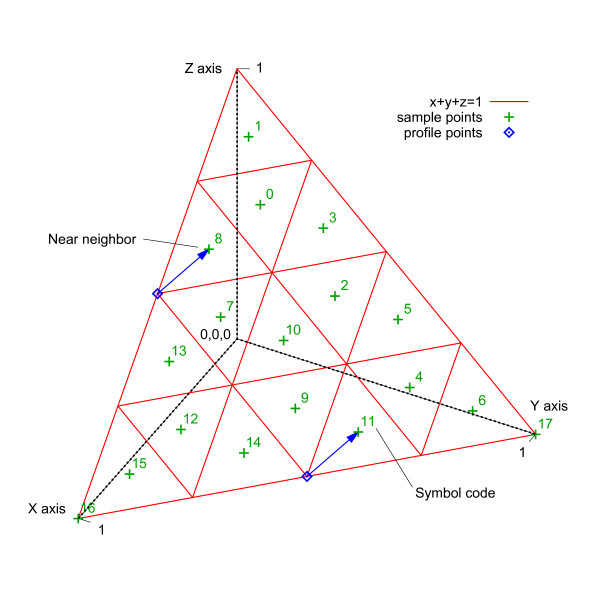
Near neighbors in profile space. Given two profile points, nearby sample points and associated symbol codes are shown.